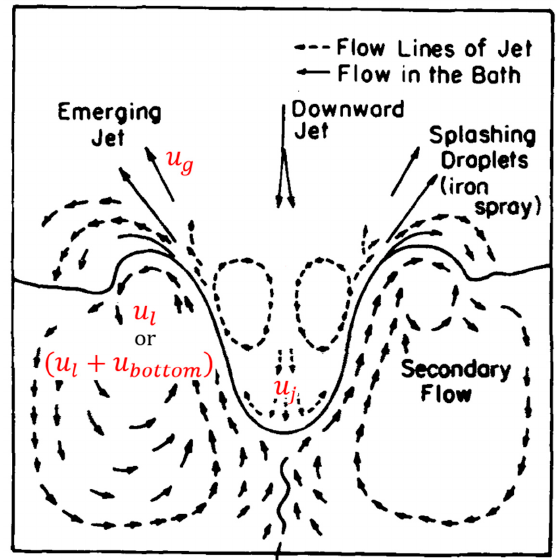
Figure 1. Fluid flow behavior at impact zone by gas jet impingement. Reproduced from [3,35], with permission of Springer, 1980. u j , u g , u l , u bottom are vertical velocity at the impingement point, tangential velocity of gas-jet, and surface renewal velocity of the metal bath due to oxygen jet and bottom stirring plumes, respectively. u j > u g >> u l . In the current model the surface renewal velocity due to top jet bottom stirring plumes is ( u l + u bottom )